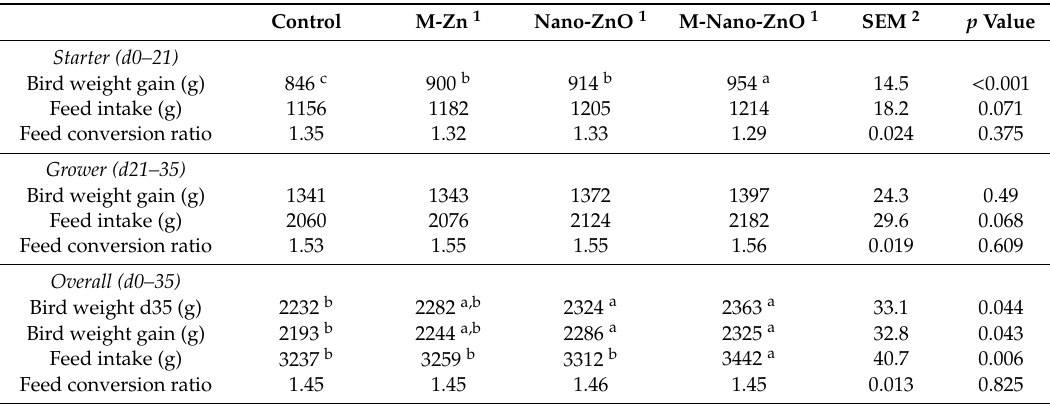
Table 3. E ff ect of zinc type on growth performance of